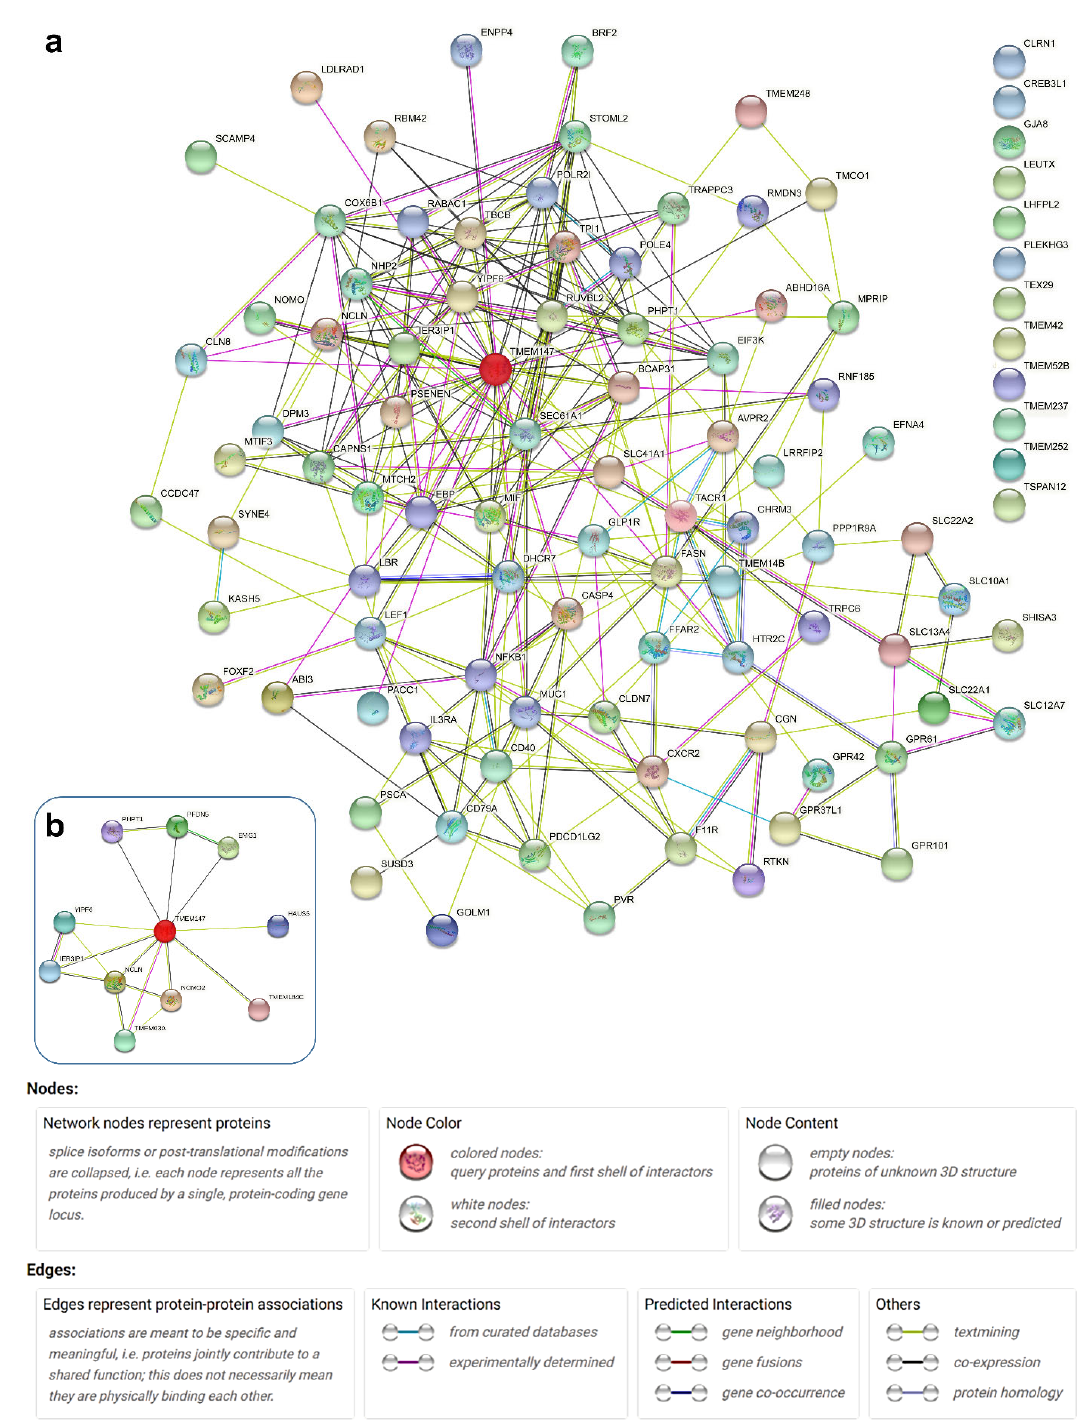
Figure 3. Network analysis for TMEM147 ‐ associated proteins. ( a ) Primary network of proteins based on our manually curated list of known interactions and reports for TMEM147 (indicated by transparent red overlay) as analyzed in String ‐ db 11.0b. Proteins without interaction in the String ‐ db 11.0b database are aligned at the top right. ( b ) Primary network of TMEM147 ‐ associated proteins as held in String ‐ d 11.0b, based on TMEM147 as input. The color code for underlying database information used by String ‐ db is given in the in ‐ figure legend. Of note, no white nodes are present, because network analysis was restricted to query proteins ( a ) or the first shell of interactors ( b ).